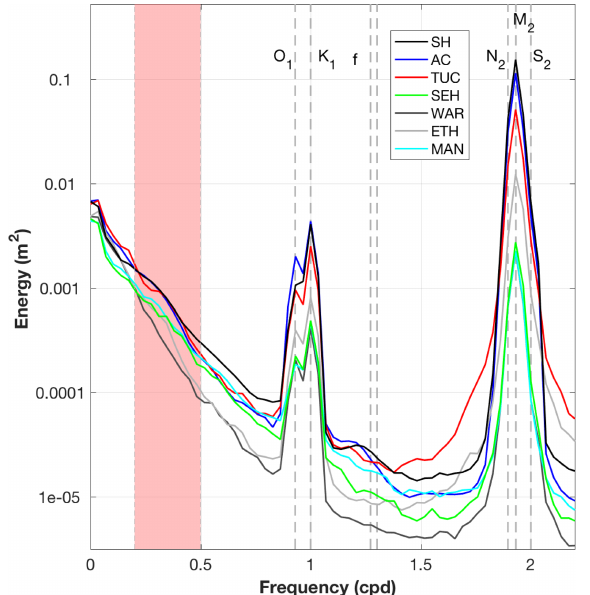
Figure 3. Energy spectra at all stations, computed using a Hanning 29d window with overlapping (50%) data segments. O 1 , K 1 , N 2 , M 2 , and S 2 label the principal tidal frequencies and f the inertial frequency. The vertical shaded area indicates the frequencies corre- sponding to the storm band (2–5d; cpd: cycles per day). See Table 1 for the key to station abbreviations and Fig. 1 for locations.